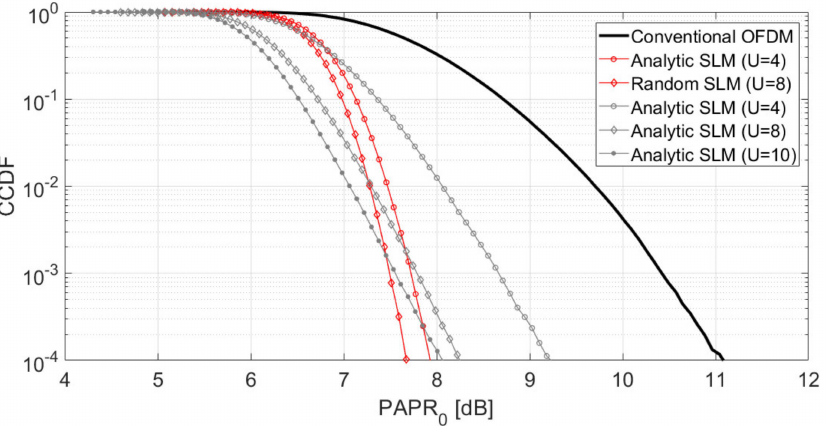
Figure 6. Comparisons of CCDF in OFDM-APSK system for conventional OFDM (bold black), random (red), and analytic (grey) PAPR reduction techniques with U = 4 (circle), U = 8 (diamond), and U = 10